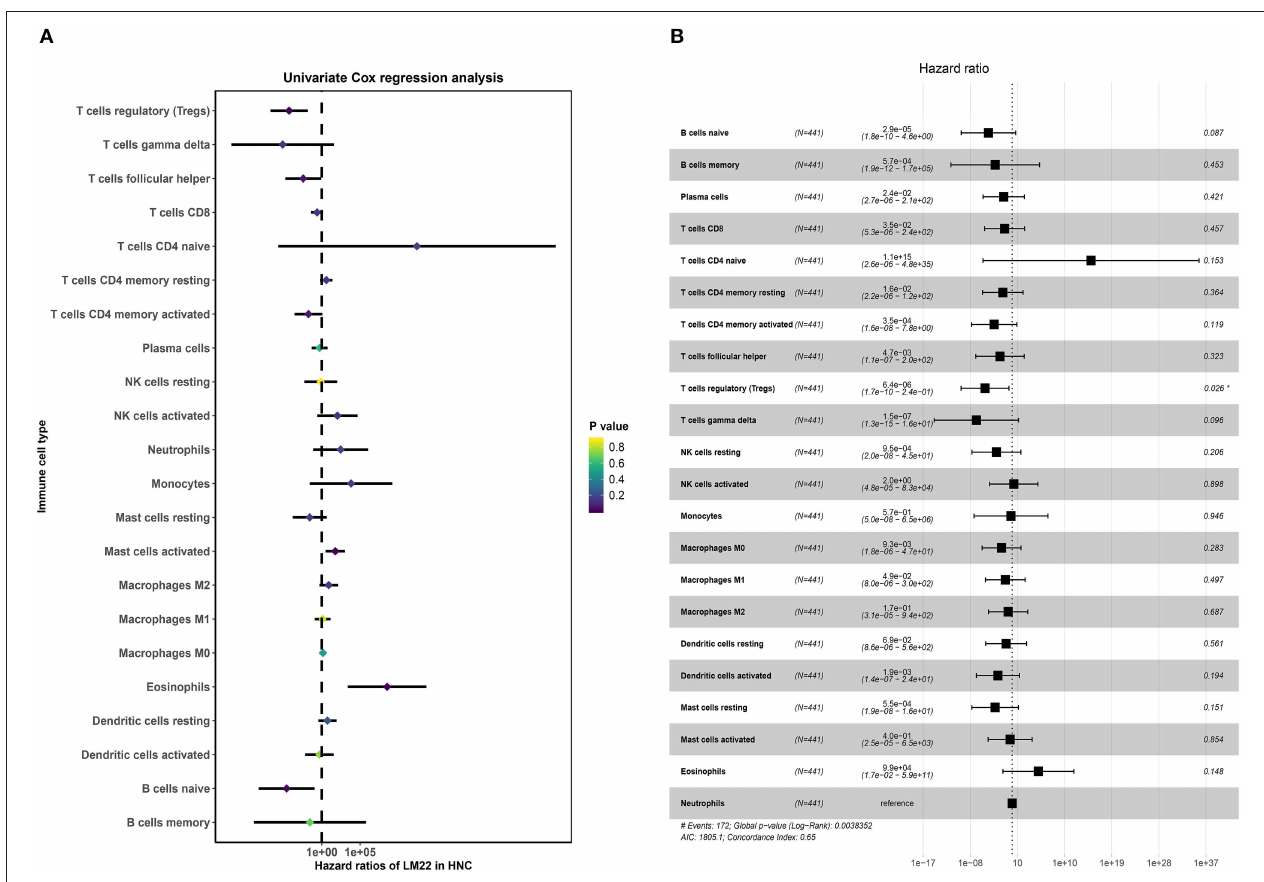
FIGURE 6 | The prognostic associations of subsets of immune cells in Cox regression analysis. (A) Univariate Cox regression analysis. (B) Multivariate Cox regression analysis.